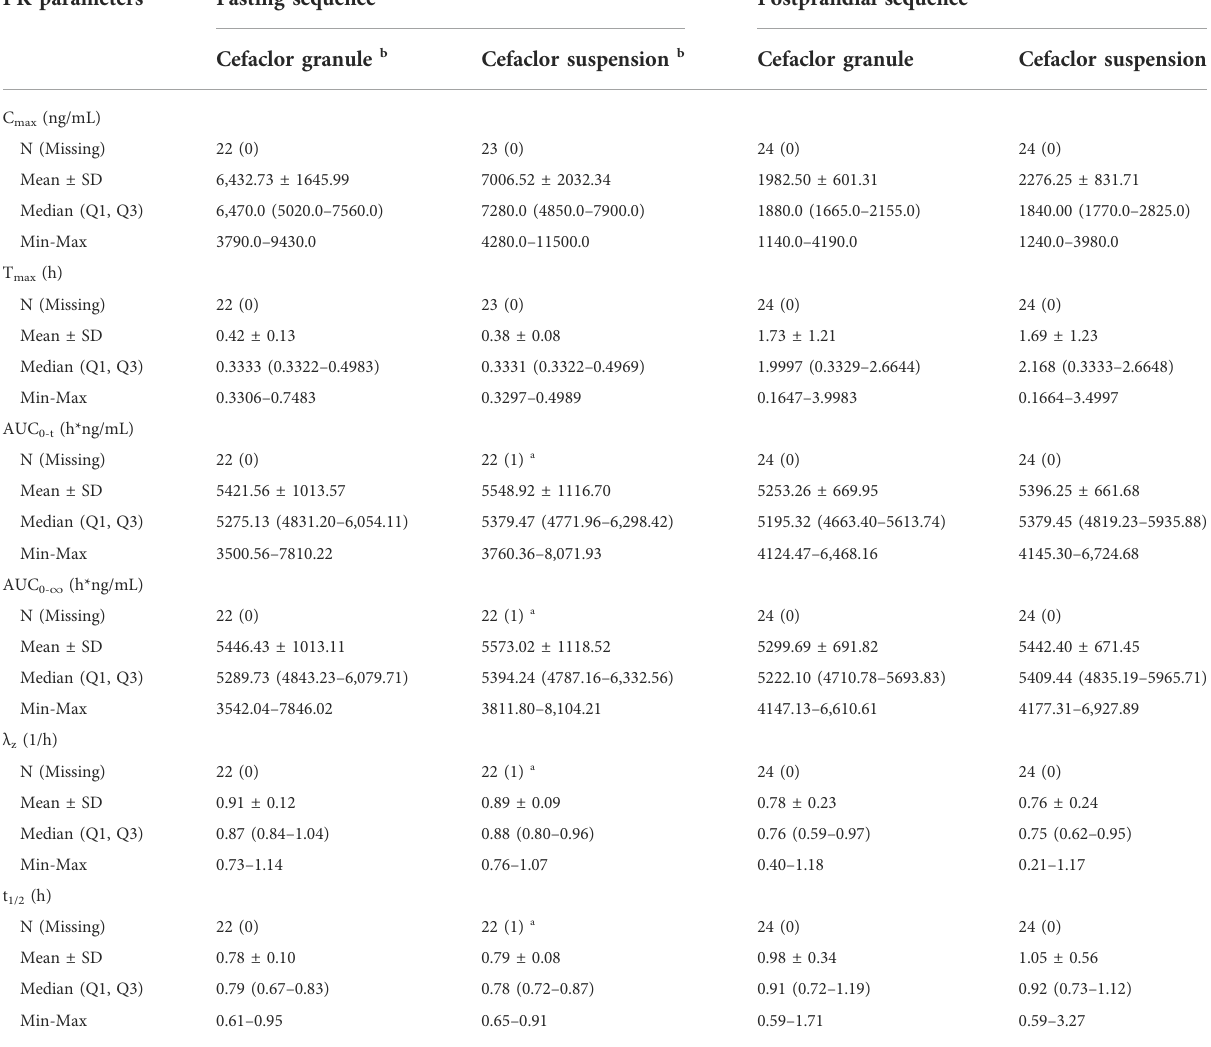
TABLE 2 Summary of pharmacokinetic parameters after oral two drugs in fasting and postprandial